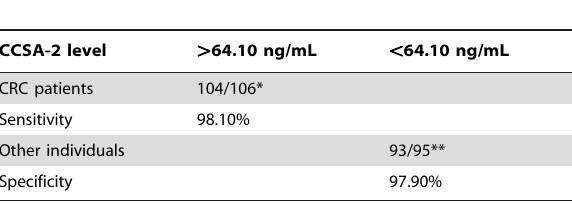
Table 3. Specificity/Sensitivity of Serum CCSA-2